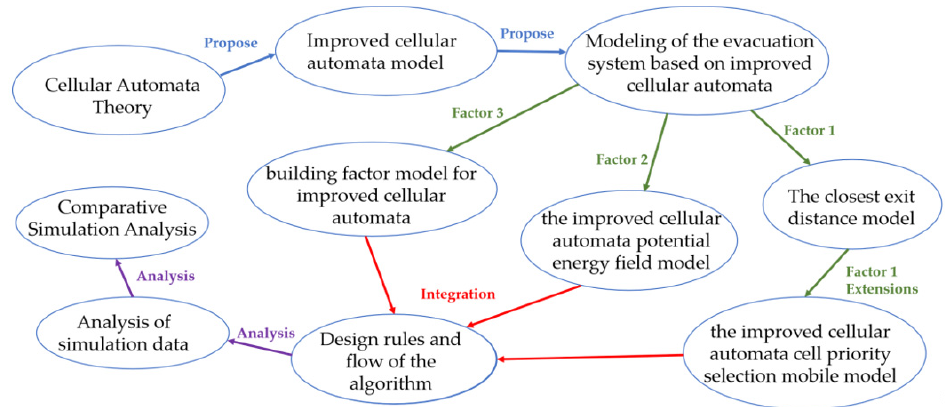
Figure 6. Overall method diagram of building evacuation model.